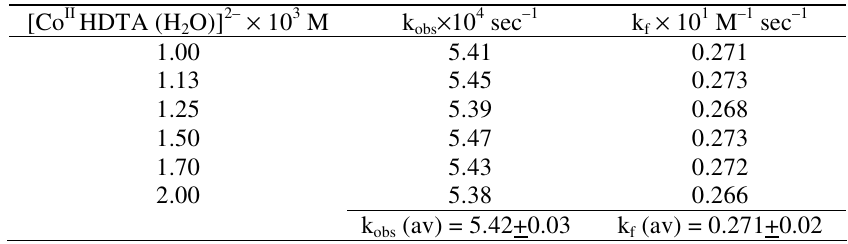
− [Co II HDTA O)] 2– with ]IO[ 2 4